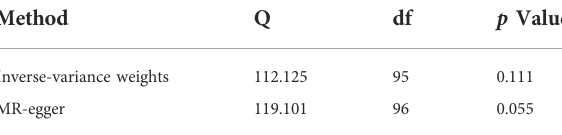
TABLE3HeterogeneitytestingofinstrumentalvariablesforvitaminD.